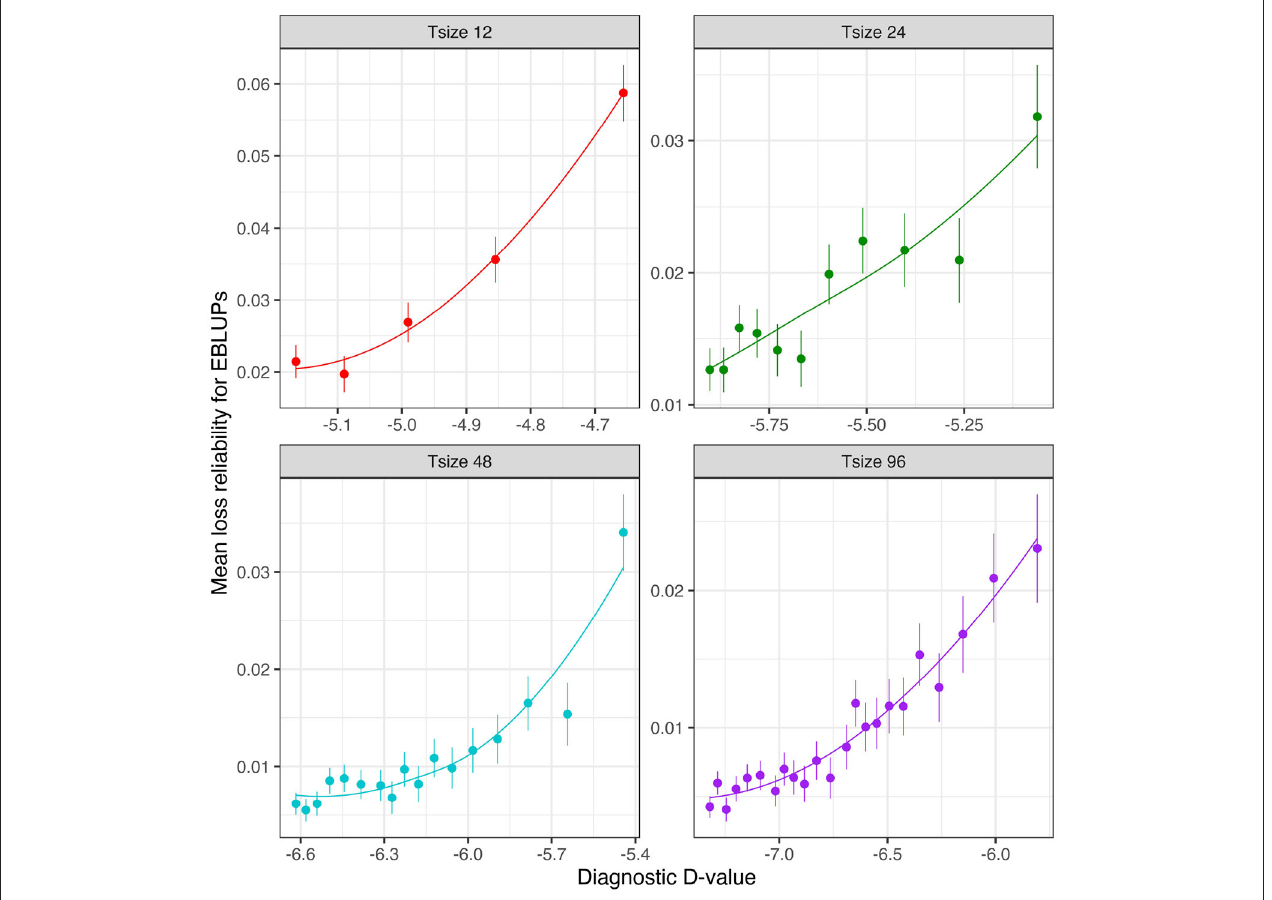
FIGURE 6 | Independent VE effects simulation study: Mean loss in reliability of the EBLUPs of VE effects for Env1 for those varieties that were present in both environments. Each panel corresponds to a different trial size (trials with 12, 24, 48, and 96 varieties) and the points correspond to a sequence of connectivity levels. Also shown are standard errors for each mean (vertical lines) and a loess smoother through the means for each